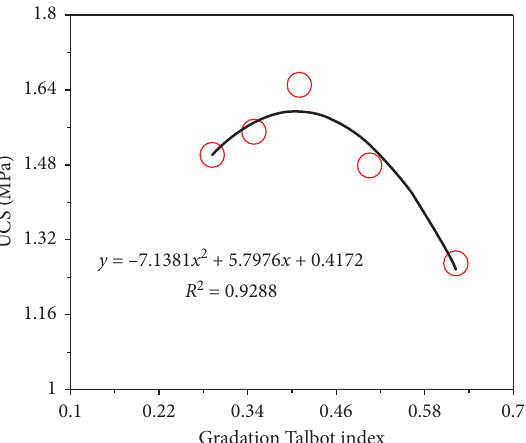
Figure 11: Relationship between gradation Talbot index and UCS.